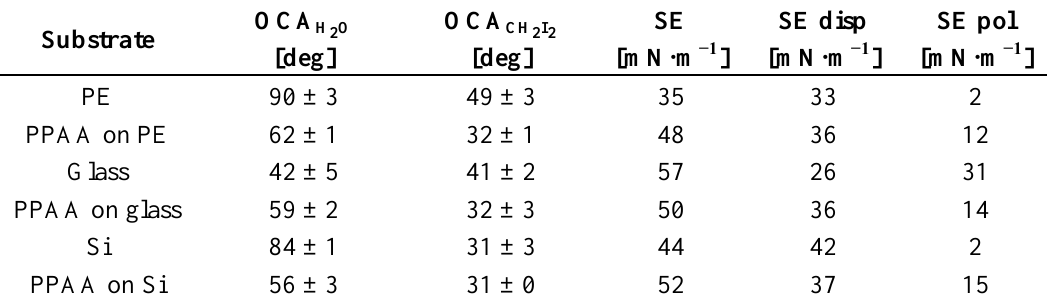
Table 1. Contact angle characterization showing the OCA different substrates coated with PPAA films and corresponding calculated surface energies (SE) (polar and dispersive contributions).